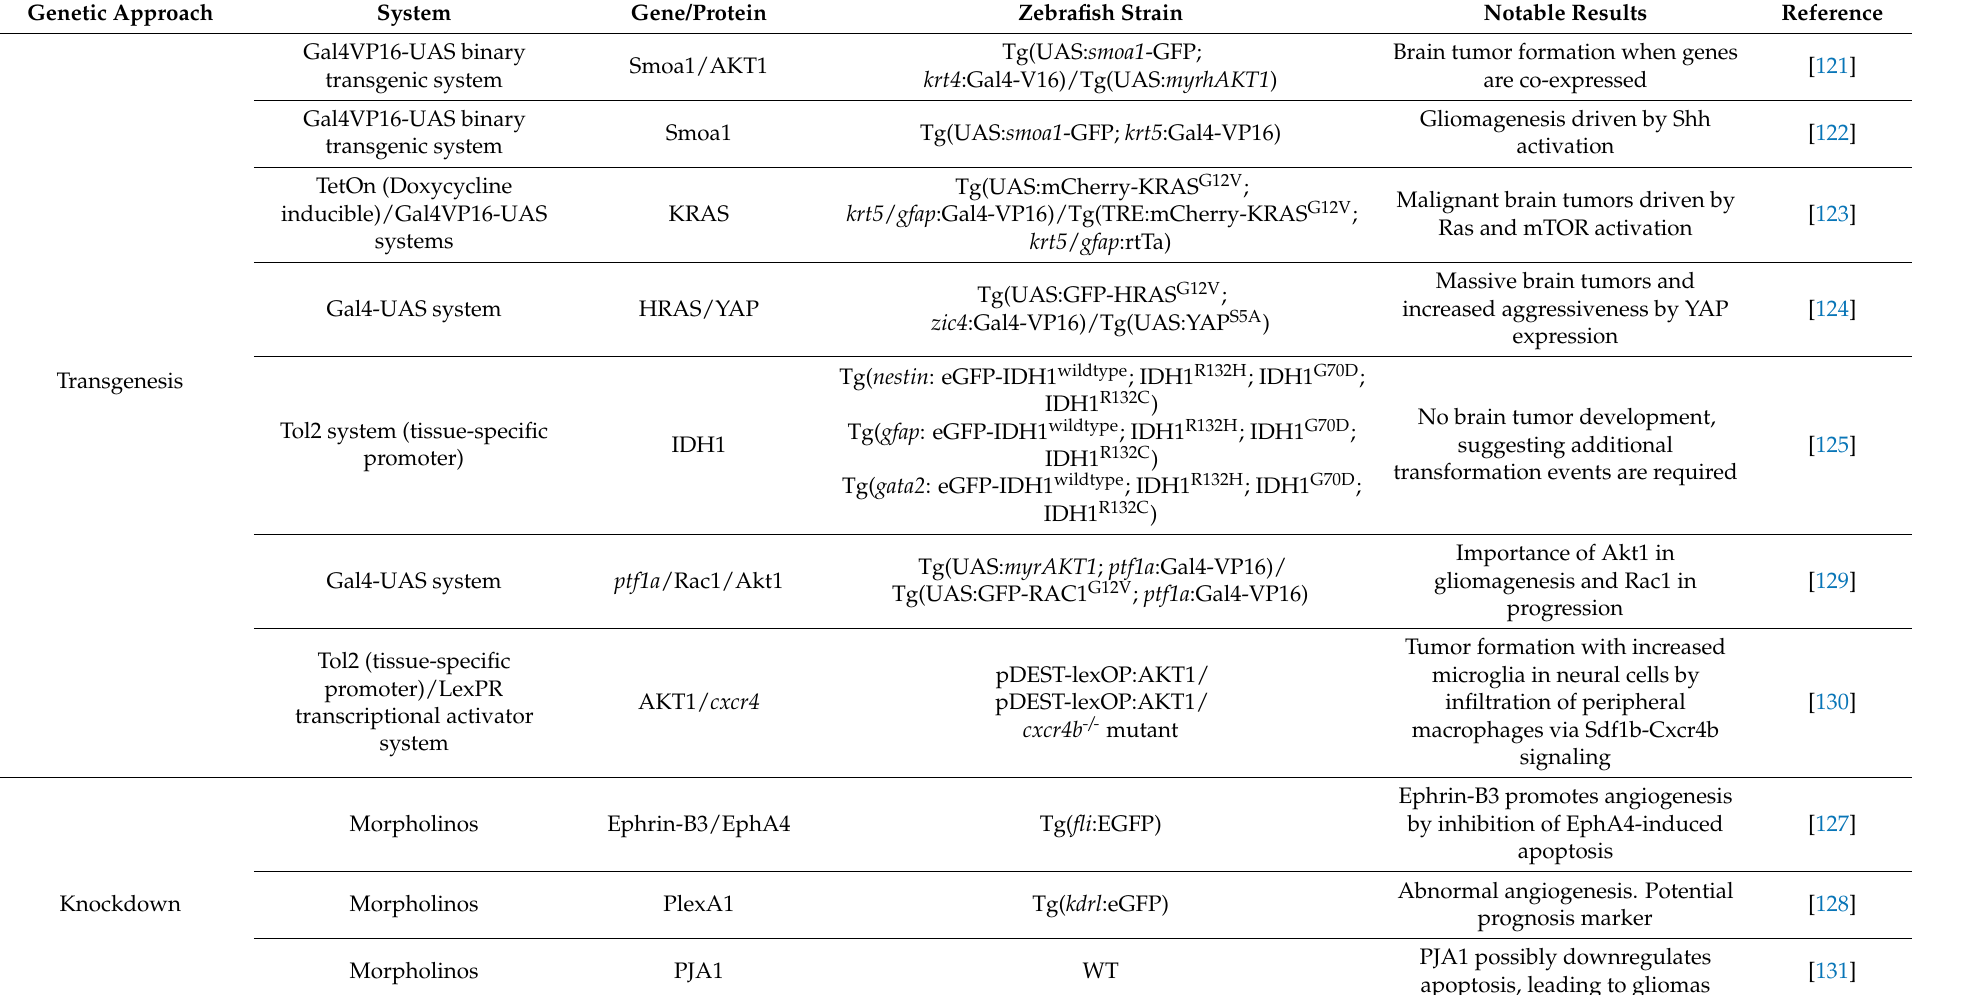
Table 1. Genetic approaches using zebrafish for modeling